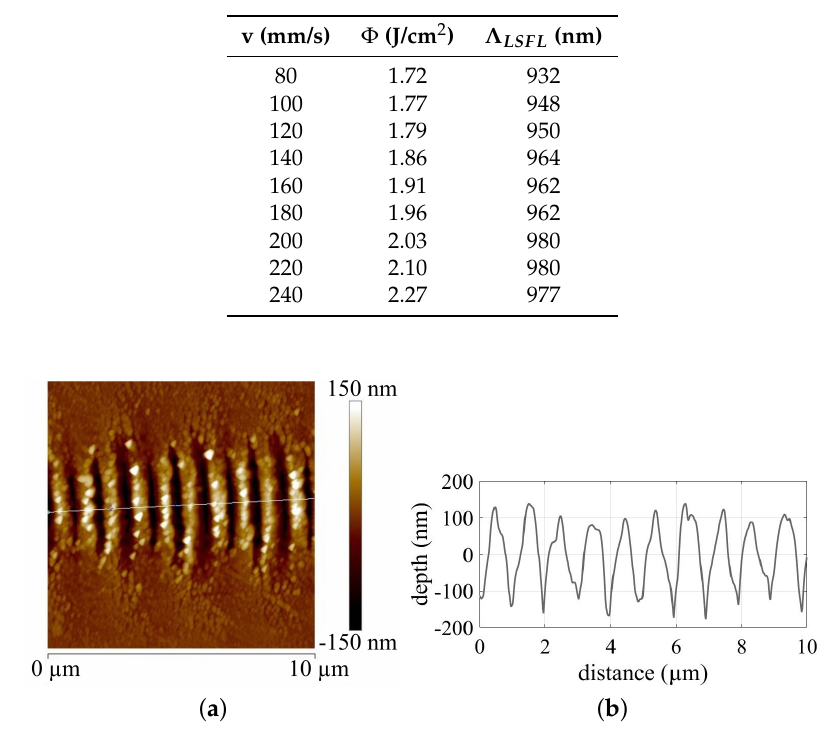
Figure 3. ( a ) AFM image of one-dimensional LSFL for scanning with v = 140 mm/s and Φ = 1.86 J/cm 2 ; ( b ) corresponding modulation profile revealing an average depth of about 260 nm and a modulation profile resembling a |sin(x)|